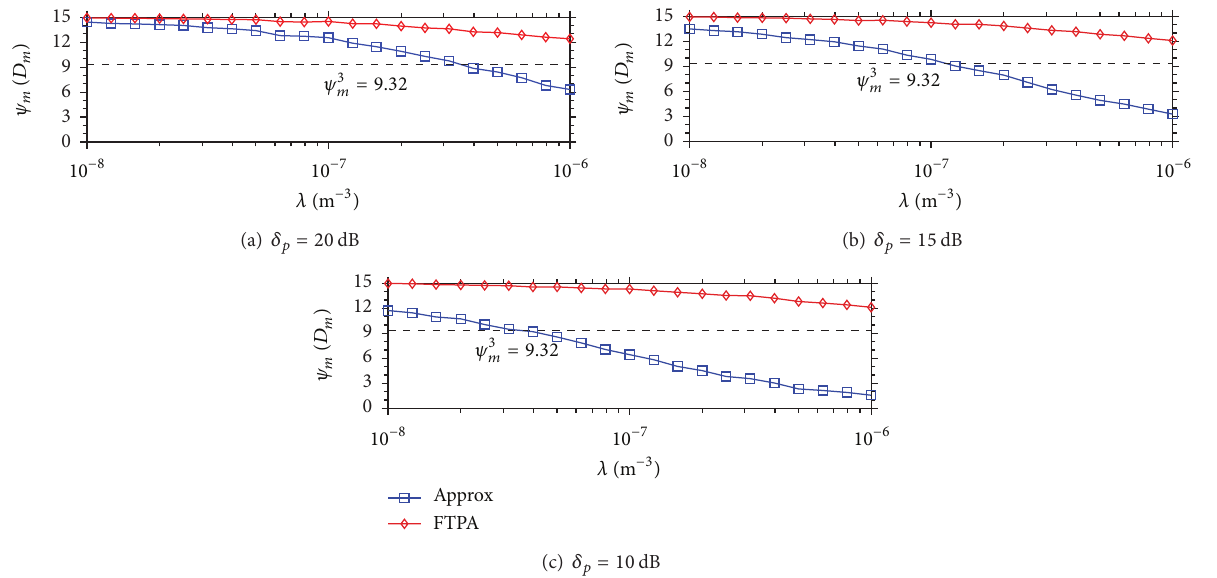
increase the overall system capacity (we discuss it in the